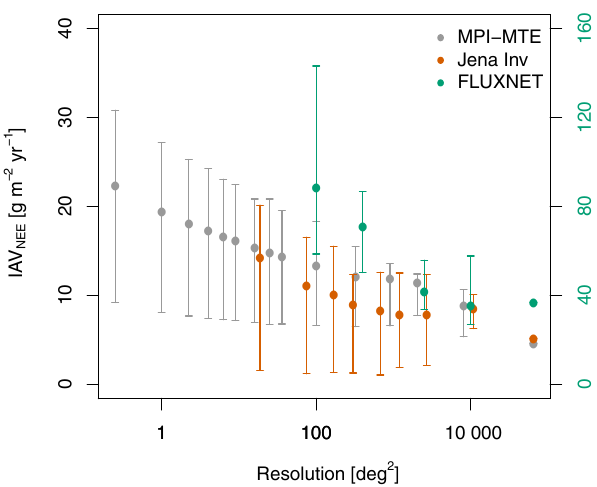
Figure 4. Dependence of IAV NEE on map resolution for FLUXNET sites (green dots), MPI-MTE (grey dots) and the Jena Inversion (red dots). Error bars represent the 25 and 75% quantiles of the IAV in the aggregated